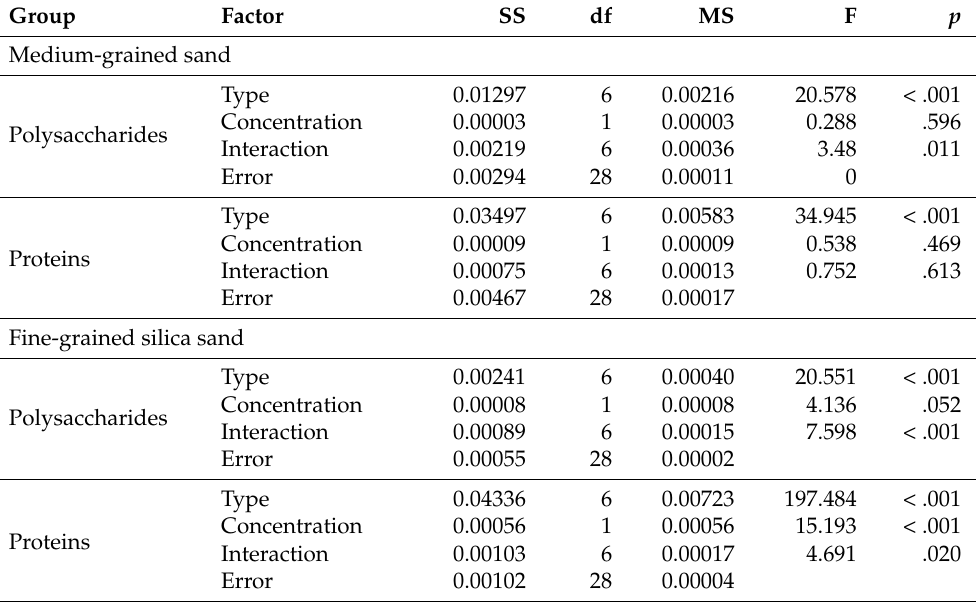
Table 3. Results of two-way ANOVA ( α = .05) of moisture retention. Percentage values were transformed via square root transformation prior to performing two-way